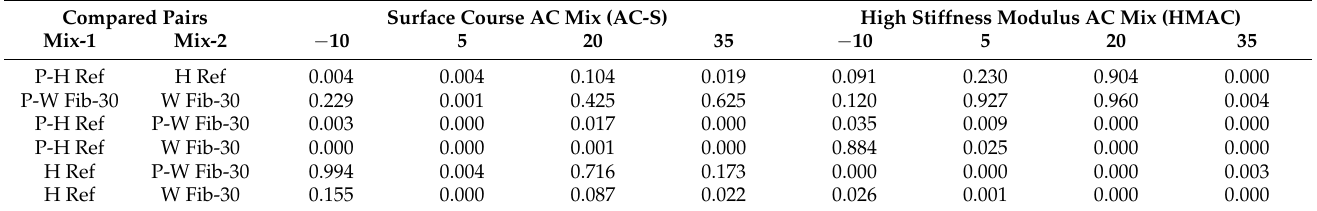
Table 6. Results of post-hoc Tukey HSD tests ( p -values) for assessment of differences between the dynamic moduli (|E*|) in mixture pairs; p -values < 0.05 denote significant differences in